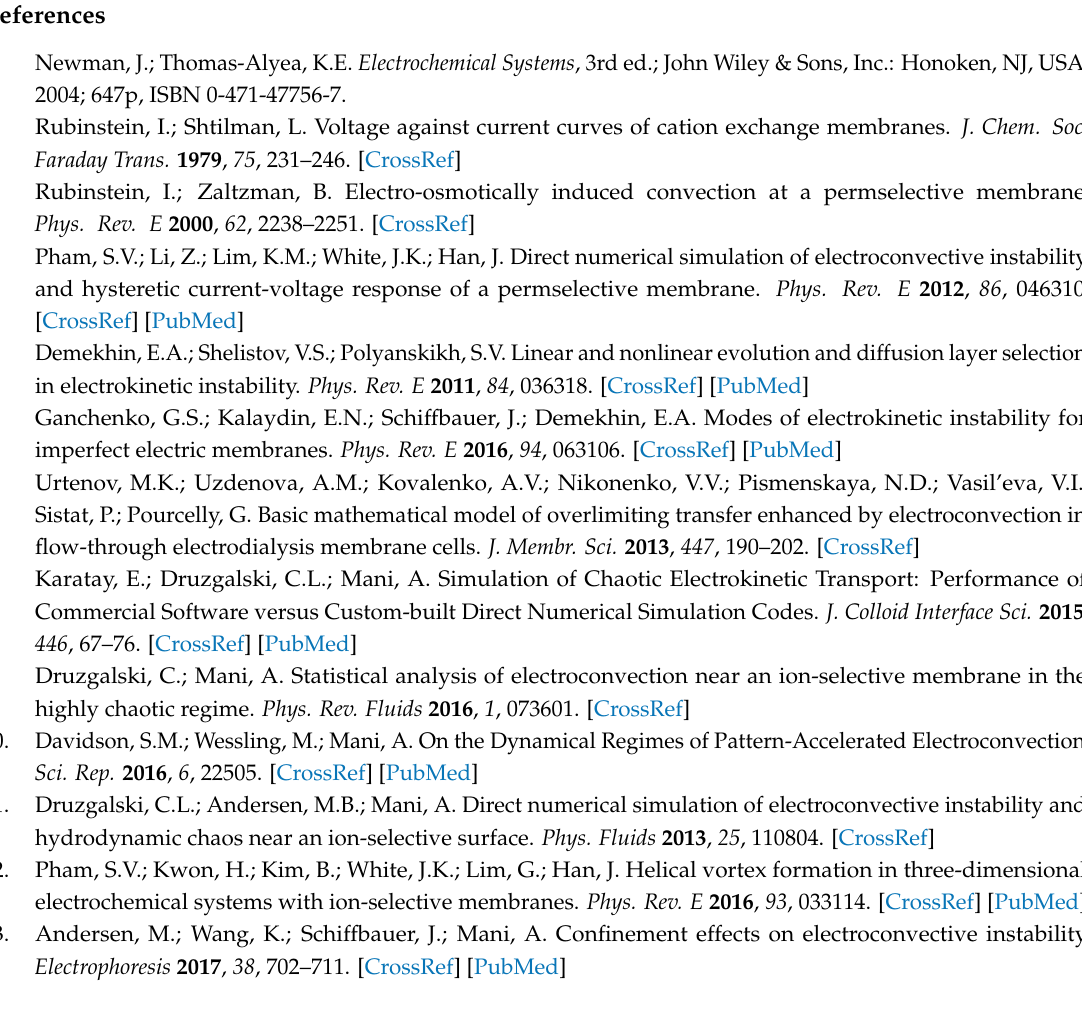
Table A2. The total time needed for computation of ∆ ϕ ( t (cid:48) ) by using different models. Relative Error, Number of Mesh The Computation Time, the Case of Model t’ = 0.239, s Elements, K γ “Primary” 0.14% 75,000 563 “Zonal” 0.14% 1000 16 “Simplified”